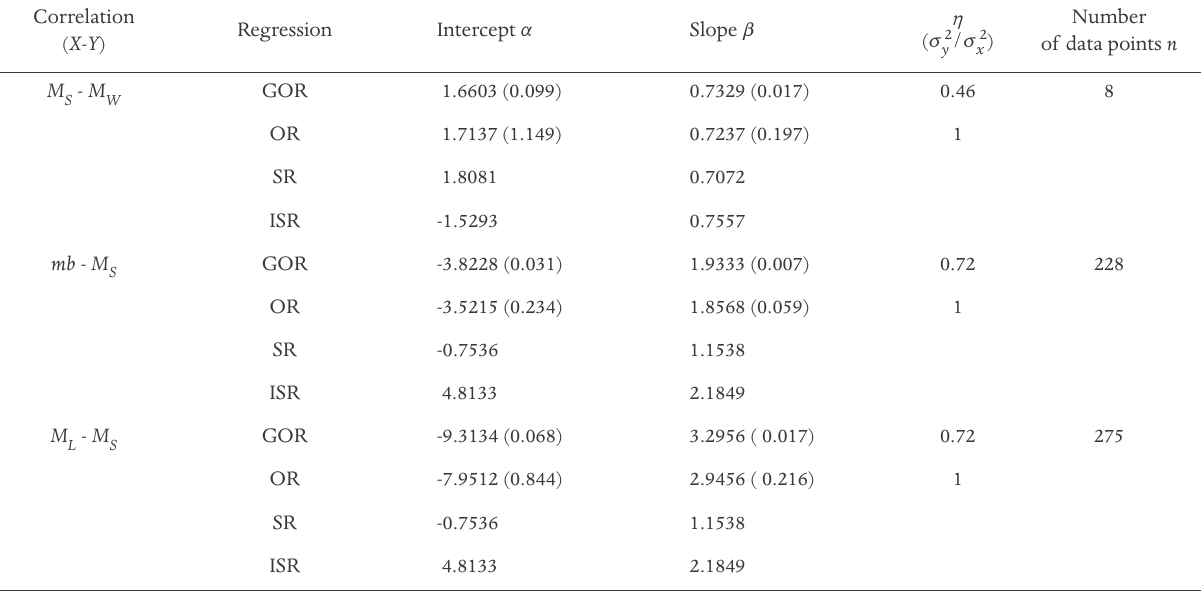
2 / v 2 ) and number of data points n ) devel- y x